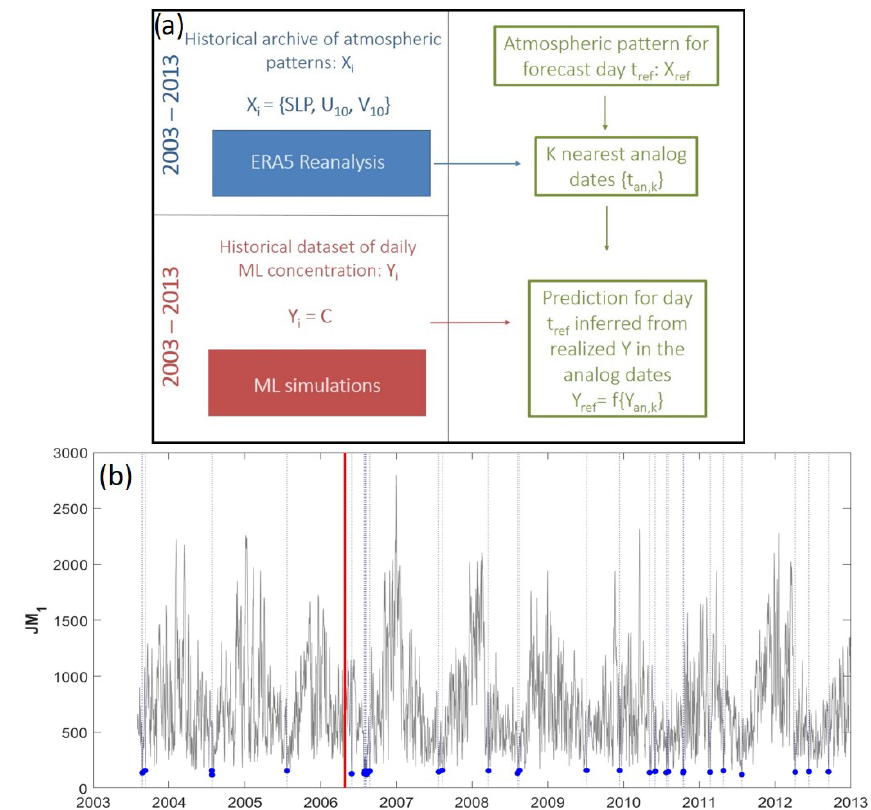
Figure 1. (a) Scheme of the functioning of the analogues method. (b) Example of the JM 1 cost function. The vertical red line marks the date forecasted ( t fcst – 26 April 2006 in the example). The thin black line is the JM 1 cost function for the whole period in the Mediterranean Sea region. Blue dots and vertical dashed lines indicate the analogue dates selected ( t an ,k ; see text for